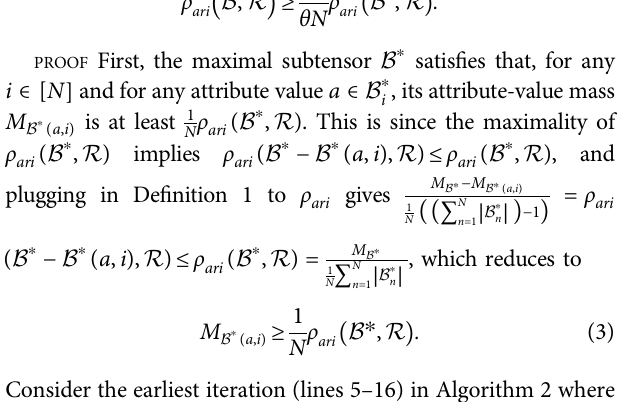
Algorithm 2). Second, applying